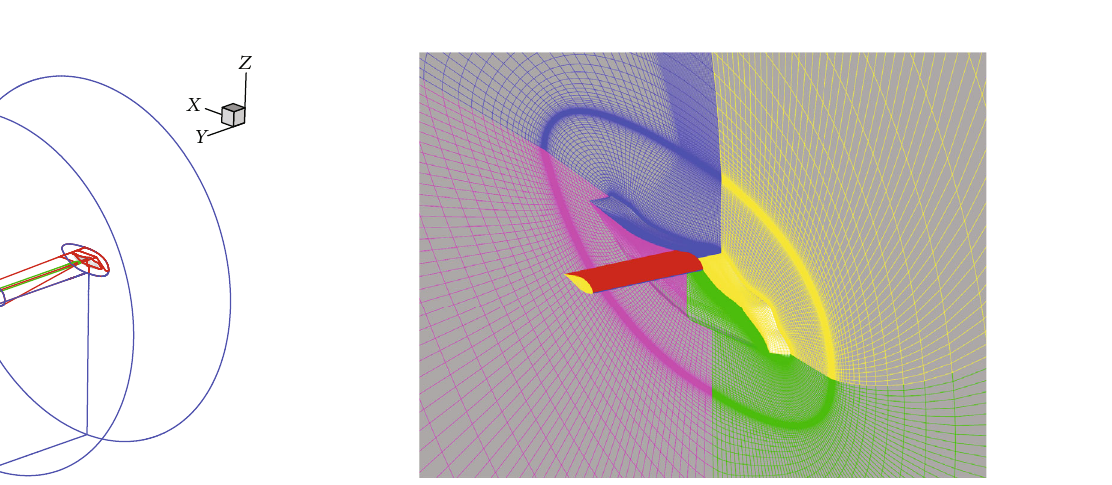
Figure 1: Simpli fi ed tilt-rotor aircraft con fi guration.